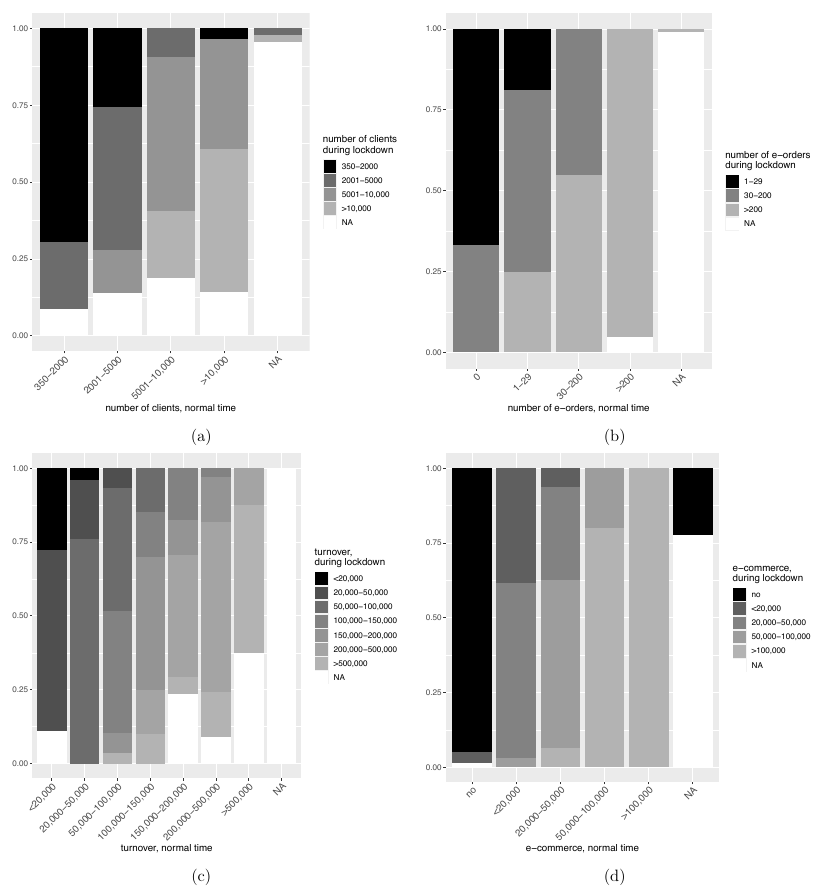
Figure A1. Comparison of turnover and order number during the lockdown vs. during normal time: weekly number of clients ( a ), weekly number of e-commerce orders ( b ), weekly turnover ( c ), weekly e-commerce turnover ( d